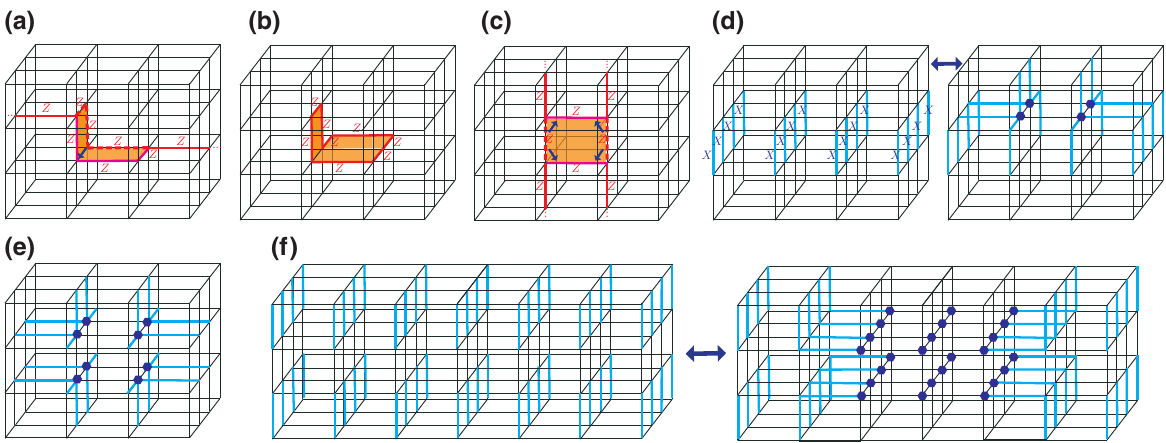
FIG. 12. An illustration of the TQFT relations Eqs. (9–14) with the 3D toric code model of Eq. (6). (a) The bending of a Z - string by multiplying two plaquette Z stabilizers (orange) corresponding to Eq. (9). The dashed lines indicate the previous Z -string location before bending. (b) A closed Z -loop can be shrunk to a logical identity by multiplying three plaquette Z stabilizers (orange) enclosed by the loop corresponding to Eq. (11). (c) The recoupling of two Z -strings via multiplying a plaquette Z stabilizer in between corresponding to Eq. (13). (d) Local bending of the X -brane by multiplying four vertex X stabilizers (blue hexagons) corresponding to Eq. (14). (e) A closed X -brane topologically equivalent to a sphere can be shrunk into a logical identity by multiplying four vertex X stabilizers corresponding to Eq. (12). (f) The recoupling of two X -branes by multiplying vertex X stabilizers corresponding to Eq.